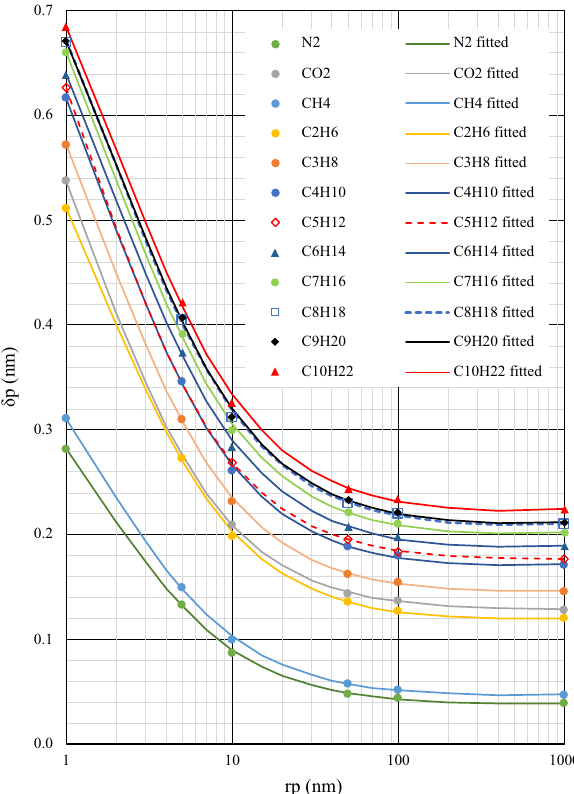
Figure 8. Measured 23 and fitted values of adsorption thickness.